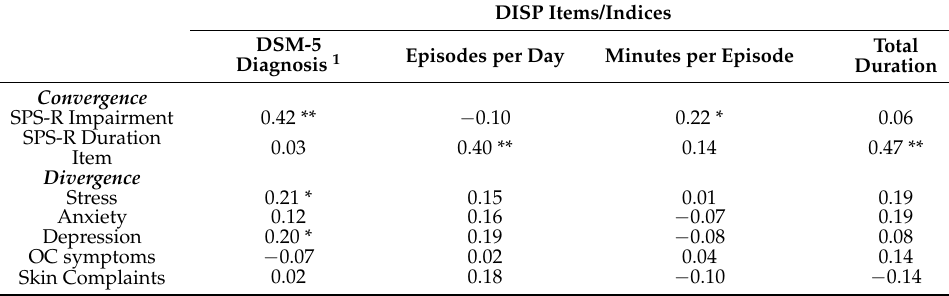
Table 4. Convergence and Divergence